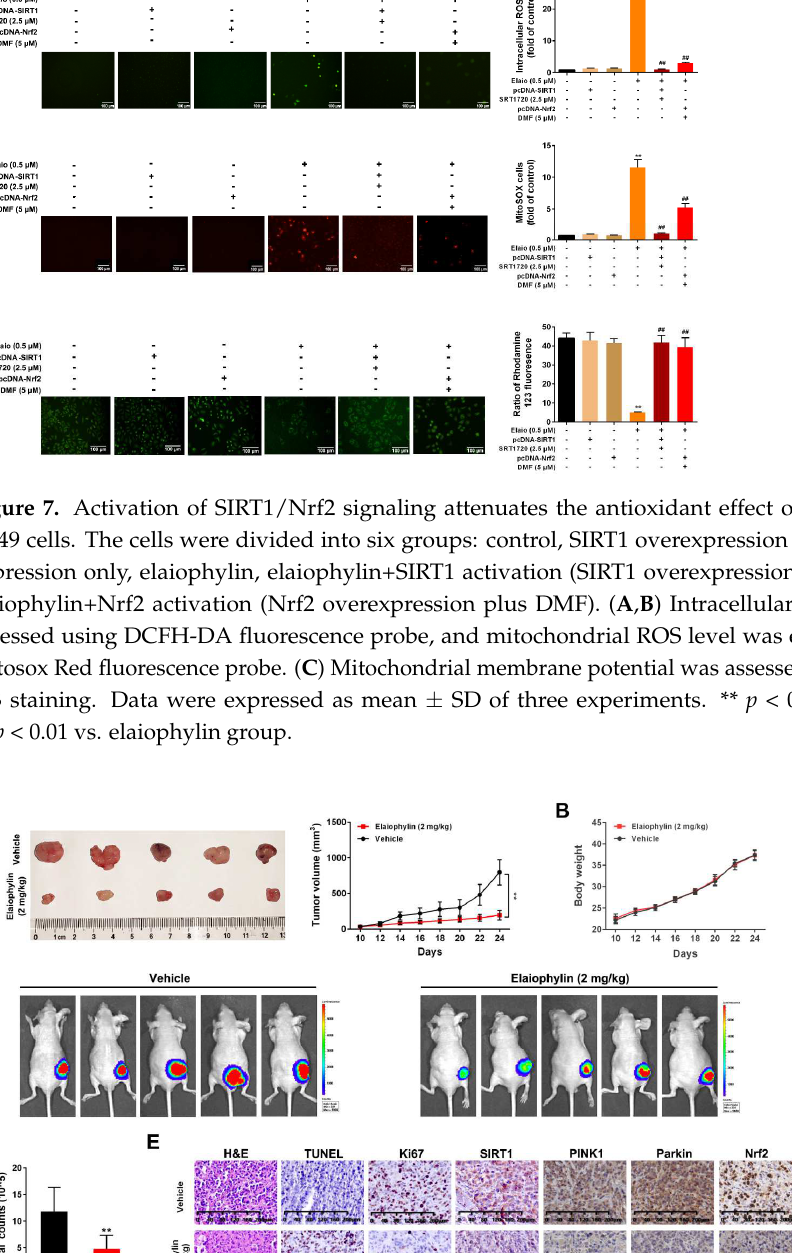
Figure 8. Elaiophylin suppresses tumor growth in an A549-xenograft model by inhibiting SIRT1. ( A ) After the elaiophylin treatment, the subcutaneous graft tumor was stripped and measured ( n = 5). The image of tumor samples was shown on the left, and the volume change measured was shown on the right. ( B ) The weight changes in subcutaneously transplanted tumor mice with or without elaiophylin treatment were recorded. ( C ) In vivo fluorescence imaging of luc-A549 subcutaneous grafted tumors after fluorescein potassium injection. ( D ) The statistical analysis of fluorescence intensity in ( C ). ( E ) H&E staining of tumor sections of Luc-A549-xenograft mice treated with or without elaiophylin (the left panel). TUNEL assay (left middle panel) and immunohistochemistry staining of Ki67 (right middle panel) and SIRT1 staining (right panel) were conducted on tumor sections of Luc-A549-xenograft mice treated with or without elaiophylin. Data were expressed as means ± SD of three experiments and each experiment included triplicated repeats. ** p < 0.01 vs. control.